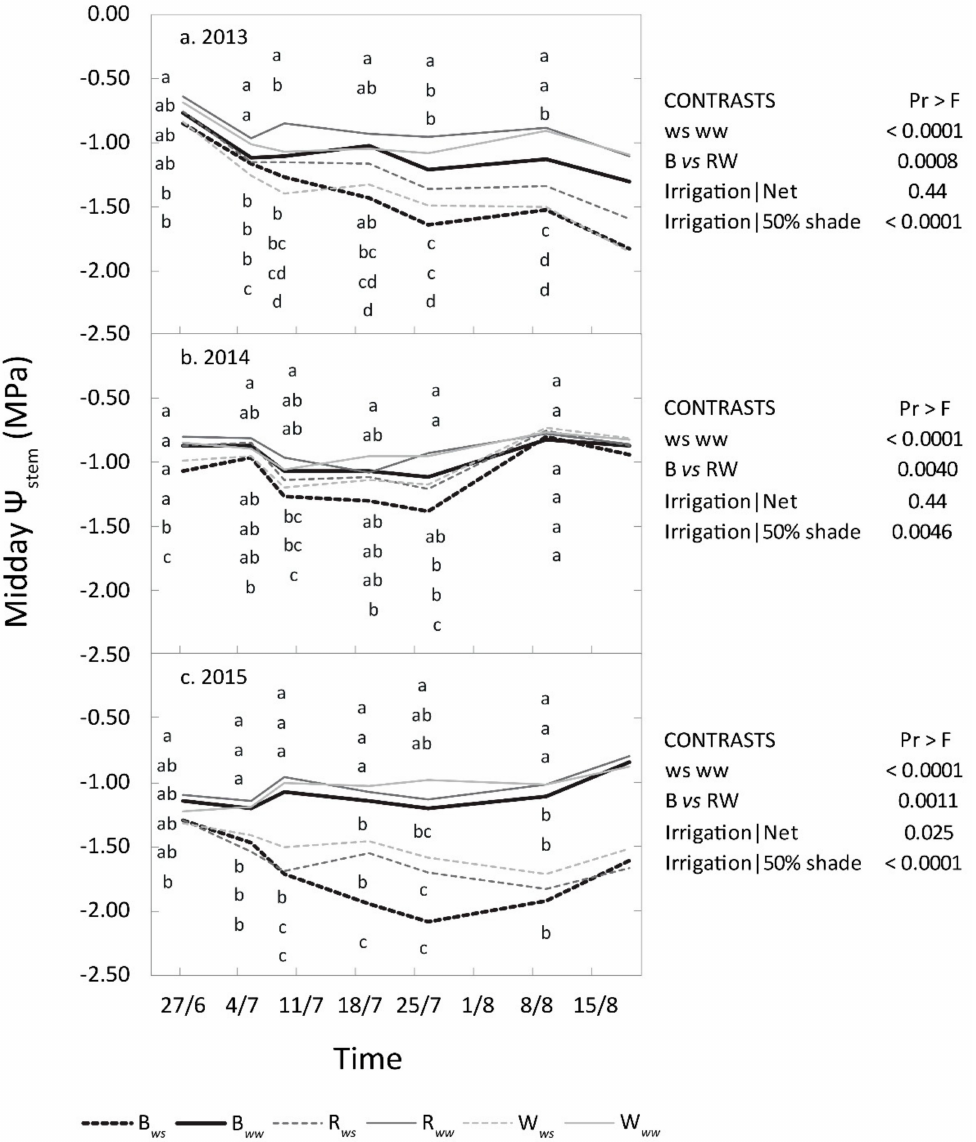
Figure 2. Seasonal patterns of midday stem water potential values throughout 2013 ( a ), 2014 ( b ), and 2015 ( c ) for each treatment. Each value represents the mean value of 4 trees. For each day of measurement, the presence of different letters represents significant differences at 95%, according to an SNK test. On the right side, linear contrast F values for each year are shown and refer to the mean seasonal value of mSWP; values below 0.05 were considered